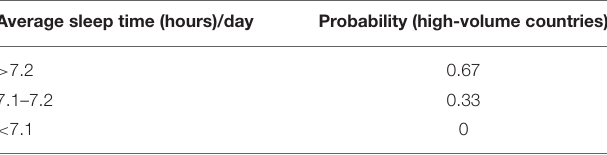
TABLE 9 | Probability of countries with high adjustable bed sales in population aging degree ranges.